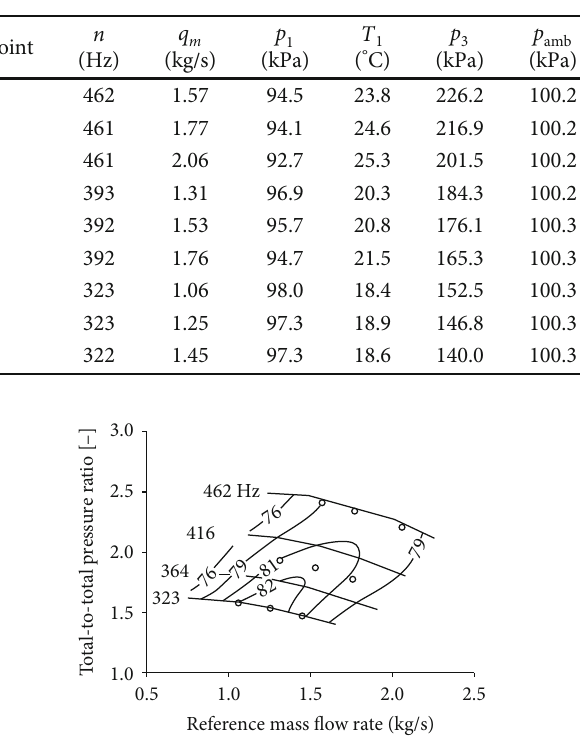
Table 1: Measured operating points.